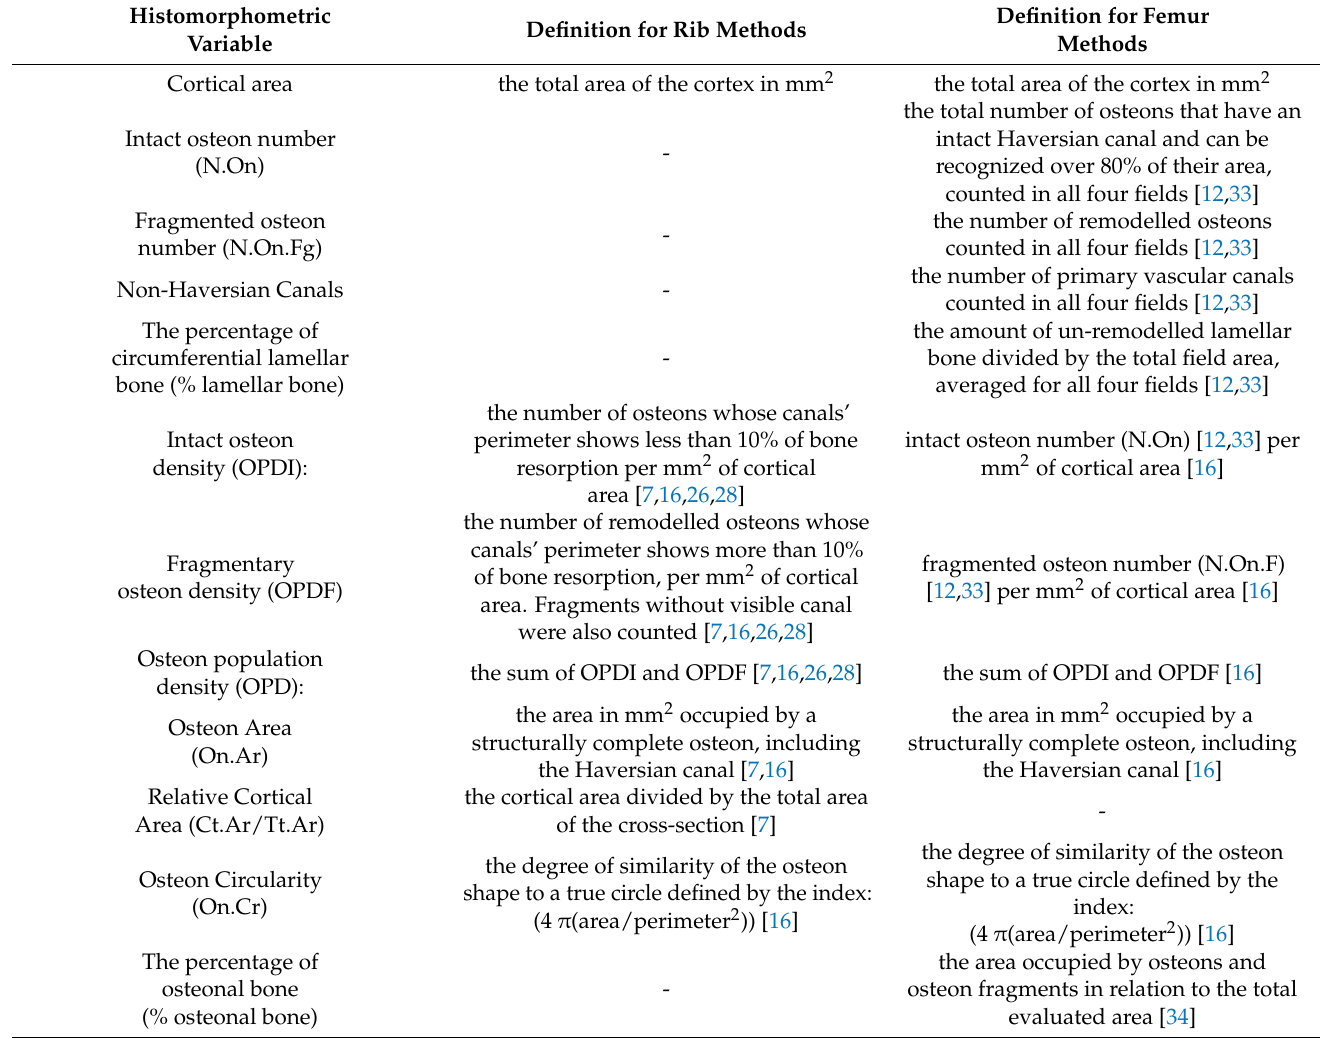
Table 2. Differences in the definition of the histomorphometric variables between rib and femur